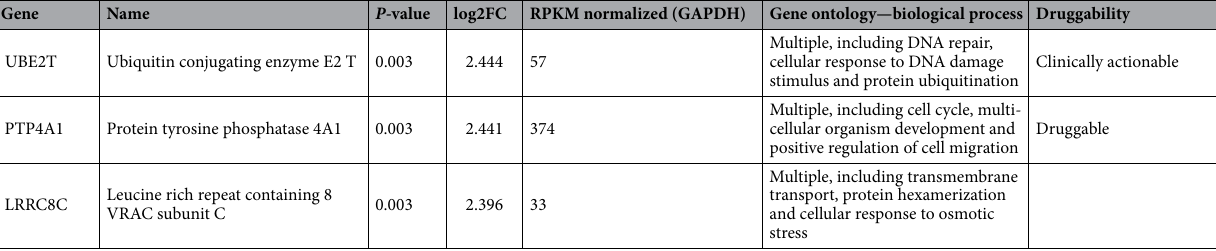
Table 1. Predicted CREM target genes that were significantly changed with a fold change of Log2 ≥ 2 after CREM siRNA treatment in the CHL-1 cell